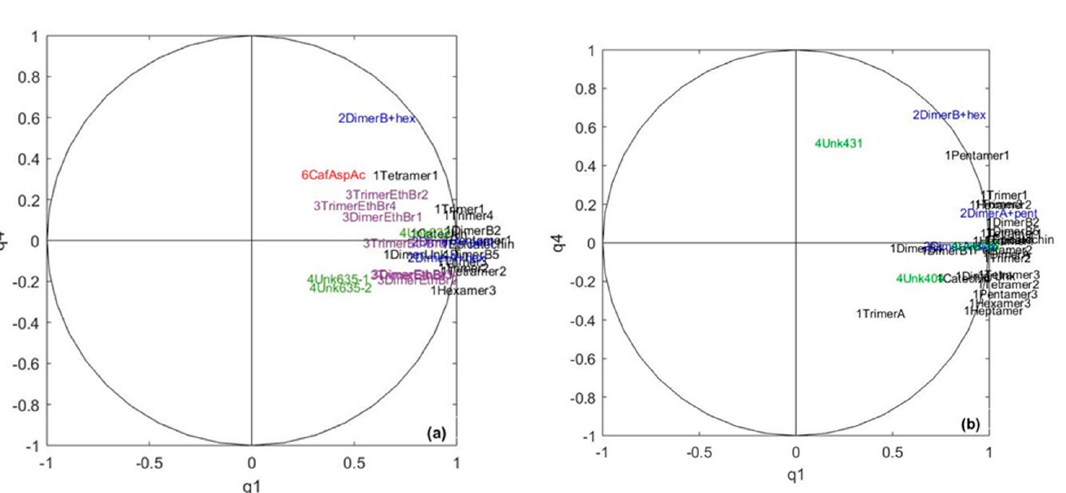
Figure 4. The CCSWA on the chocolate and cocoa data, a sample projection in the common space q1– q4. 1 = core pole 1, 2 = core pole 2, 3 = core pole 3, 4 = core pole 4 and 0 = samples not belonging to any core pole.